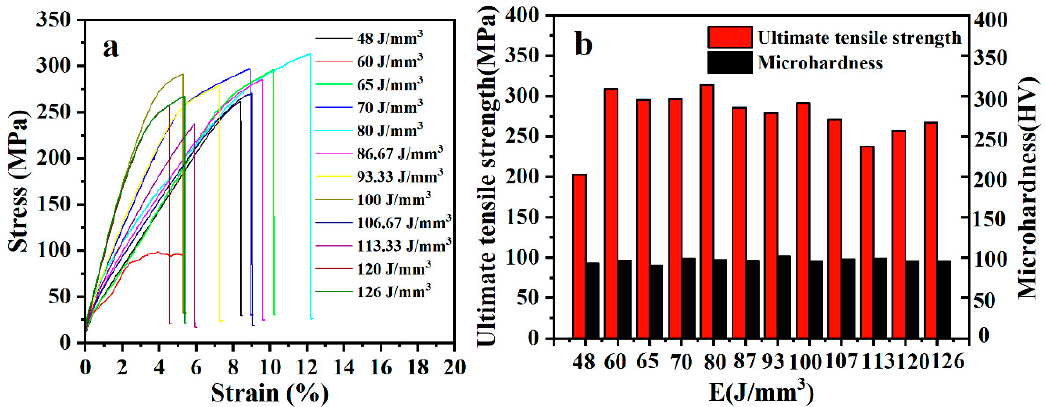
Figure 11. ( a ) Stress-strain curves, ( b ) UTS and microhardness of AS41 samples formed by SLM at different laser energy densities.